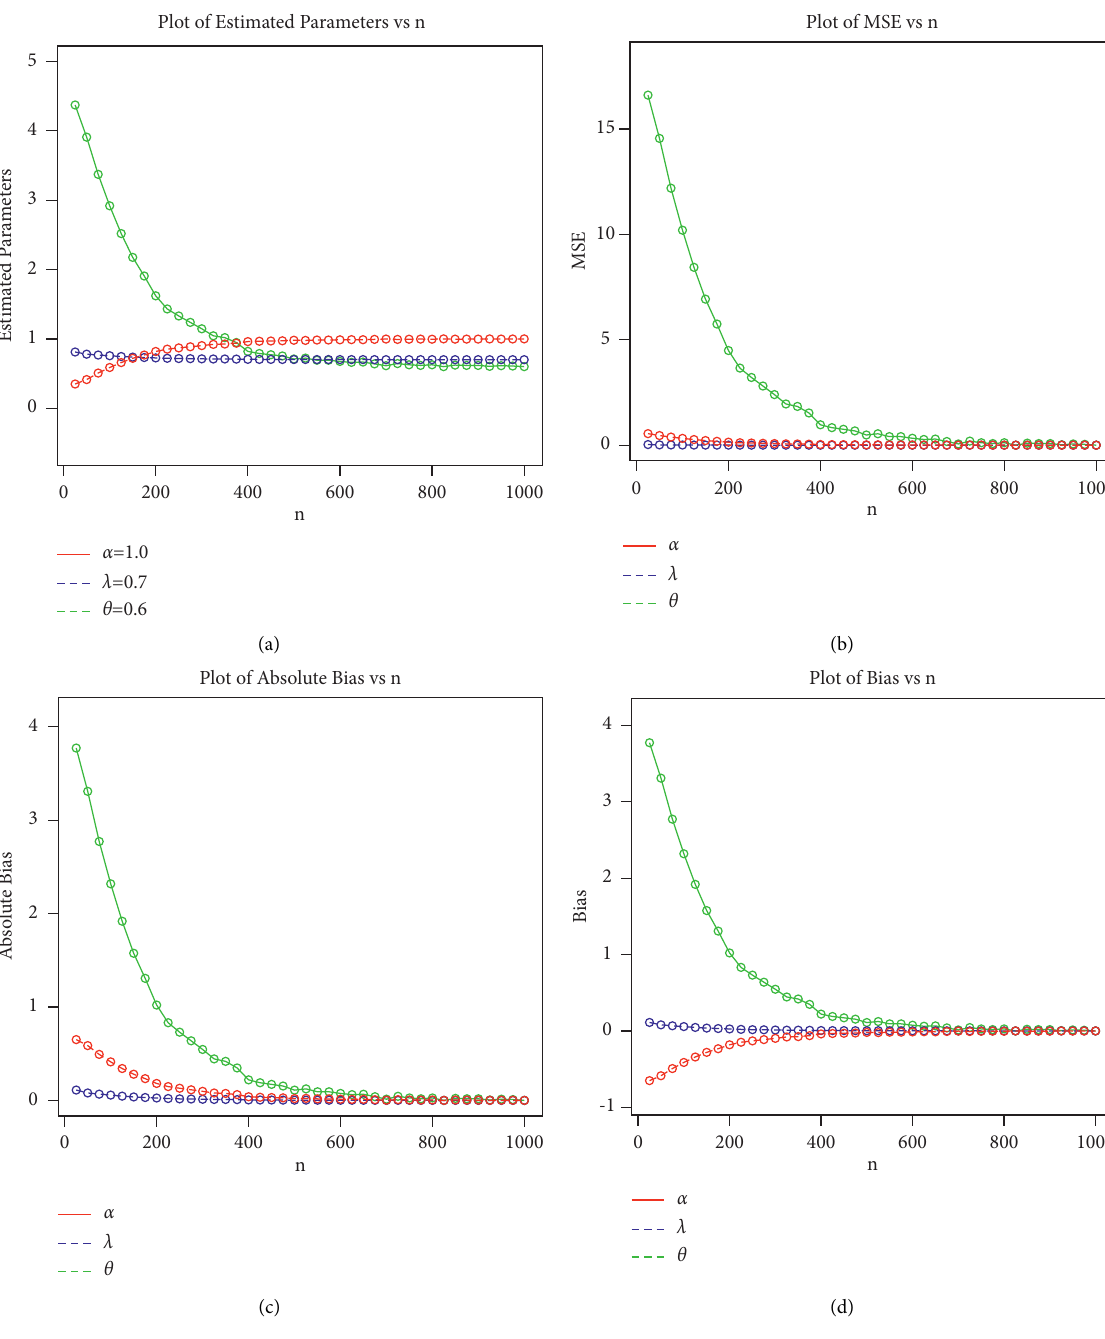
Figure 4: The plots of estimated parameters, MSEs, absolute bias, and bias for the NEE-W model using the results of set Table 3: MLE’s and their standard errors for the proposed, APTW, Ku-W, and EFW models.